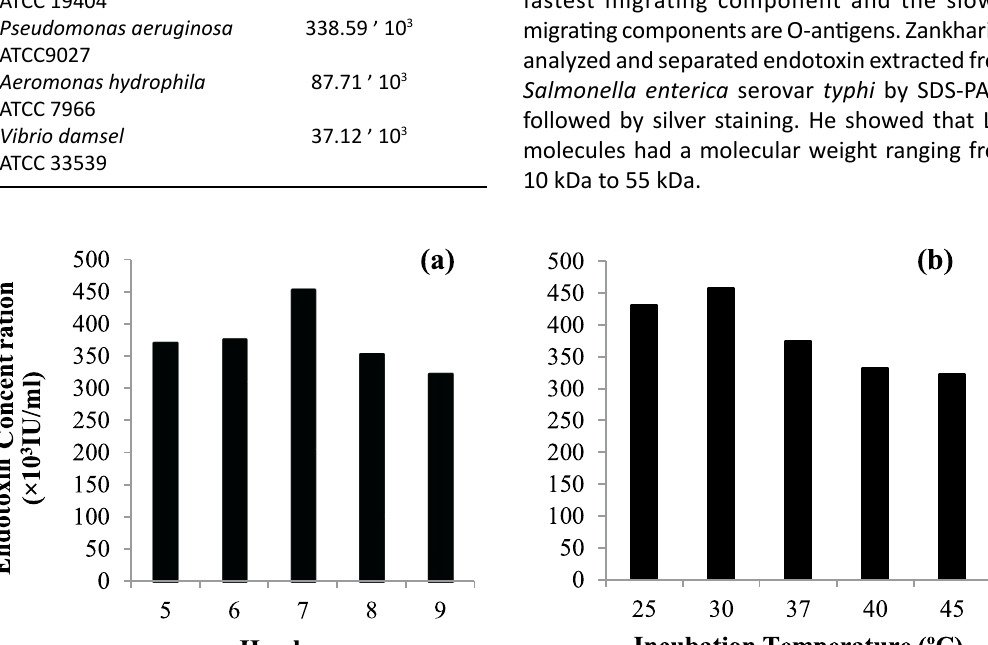
Fig. 1 . Effect of different pH values (a) and incubation temperature (b) on the endotoxin production by P. aeruginosa ATCC 9027